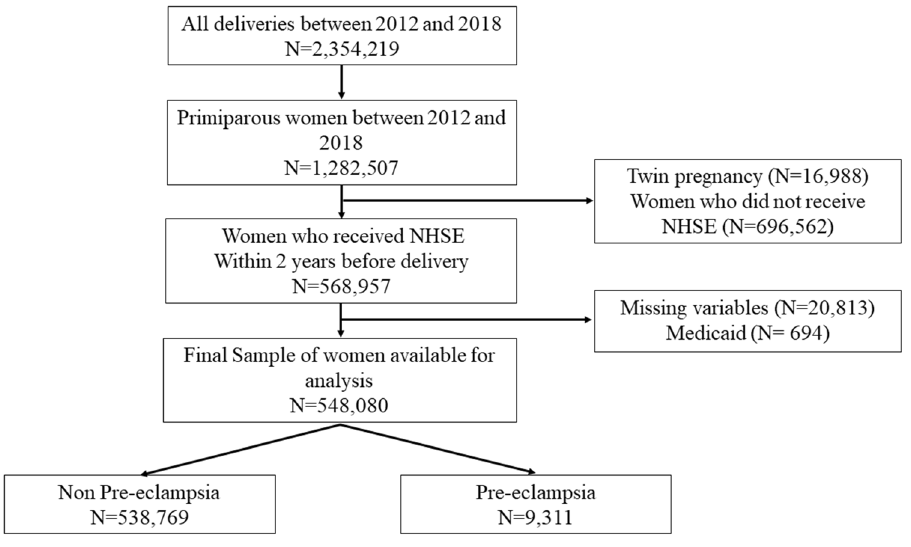
Figure 1. Flowchart of the